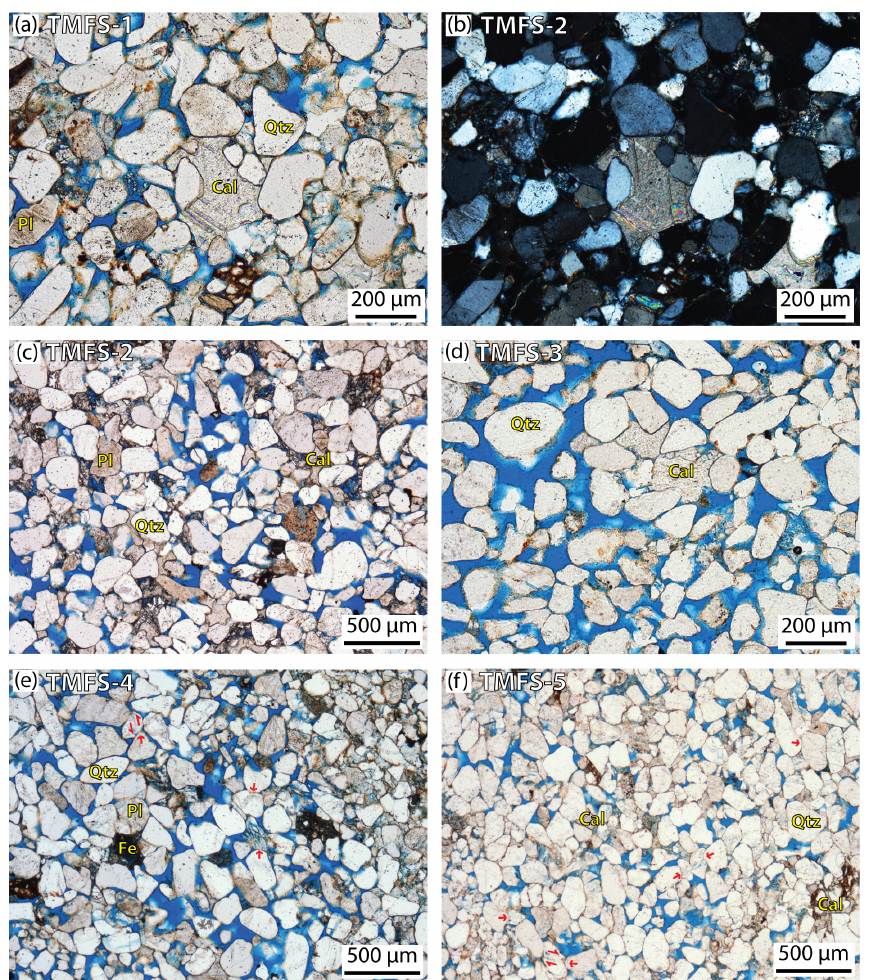
Figure 9. Thin section photomicrographs showing host rock composition structure and porosity. Note overall decrease in porosity (blue dye staining) and increase in deformation from sample TMFS-1 through to TMFS-5. (a) Undeformed host rock sample TMFS-1 viewed under plane polarized light (ppl) showing well-sorted subarkose host rock, variable porosity ∼ 9.4%–13.8% due to patchy calcite spar (note large poikilotopic calcite spar in centre of section); (b) Same section as (a) viewed under cross polarized light (xpl); (c) Undeformed host rock sample TMFS-2 (viewed in ppl) showing a well-sorted subarkose host rock, total porosity ∼ 12%, and patchy calcite spar; (d) High porosity zone (23.4%) in sample TMFS-3 (ppl); (e) Deformed host rock sample TMSF-4 (ppl), 16.4% porosity, note the pressure solution, embayed contacts and intragranular microcracks and microfractures (both tensile and shear fractures observed) in multiple quartz grains (see red arrows for examples); (f) Deformed host rock sample TMFS-5 (ppl) showing markedly reduced porosity (9.1%), further deformation structures (intragranular fractures, embayed contacts and pressure solution), apparent grain size reduction and tighter pack in of grains. Cal: Calcite spar; DB: Deformation Band; Fe: Iron staining; Pl: Plagioclase Feldspar; Qtz: Quartz. Red arrows highlight zones of pressure solution, embayed contacts, and microfractures. Porosity values from ImageJ image